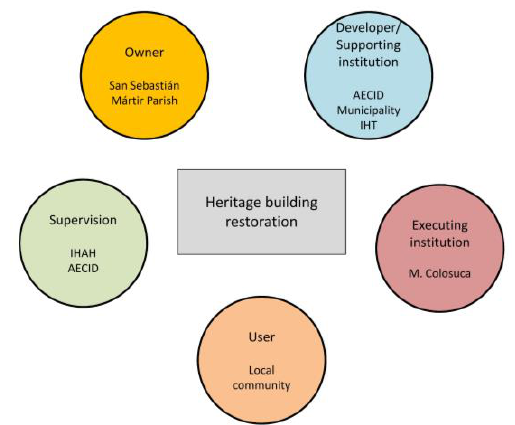
Figure 2. Diagram of agents involved and functions